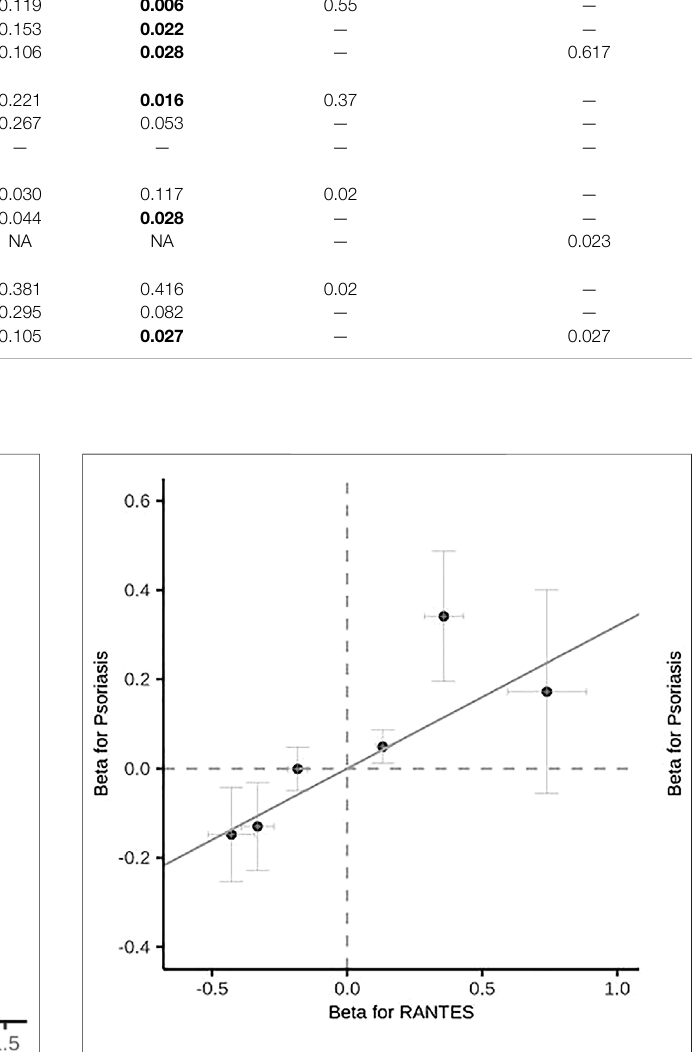
FIGURE 2 | Scatter plot of the effects of IVs on RANTES levels and the risk of psoriasis Causal Effects of Cytokine Levels on the Risk of Psoriasis Vulgaris